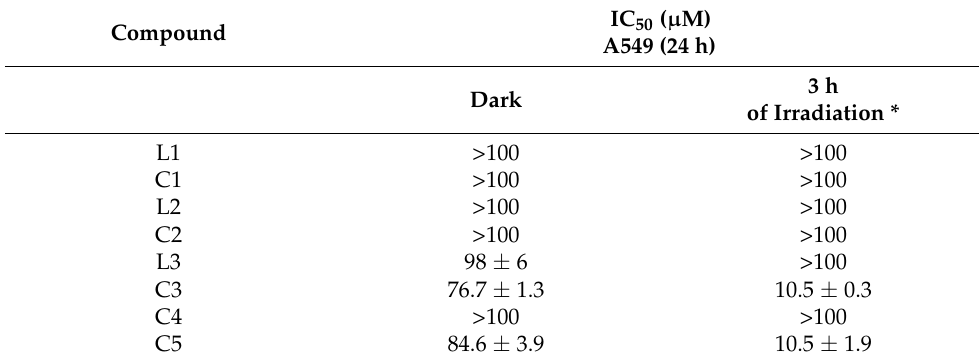
Table 2. Cytotoxicity of the ligands L1, L2, and L3, and the complexes C1, C2, C3, C4, and C5 (IC 50 values) towards A549 human lung cancer cells after incubation for 24 h in the absence (dark) and presence of blue light irradiation for 3 h ( λ = 420 nm, power 4.5 J/cm 2 ). The IC 50 of [( η 6 - p - cym)Ru(N,N (cid:48) -bpy)Cl](PF 6 ) (C4) and [( η 6 - p -cym)Ru(N,N (cid:48) -bpy)L](SO 3 CF 3 ) 2 (L = N -4-formylpyridine- 2-quinolinecarboxaldehydethiocarbohydrazone) (C5) are reported for comparison. IC 50 ( µ M) Compound A549 (24 h) 3 h Dark of Irradiation * L1 >100 >100 C1 >100 >100 L2 >100 >100 C2 >100 >100 L3 98 ± 6 >100 C3 76.7 ± 1.3 10.5 ± 0.3 C4 >100 >100 C5 84.6 ±